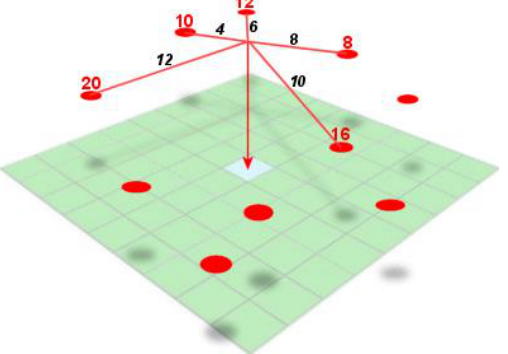
Figure 3. Cressman Analysis